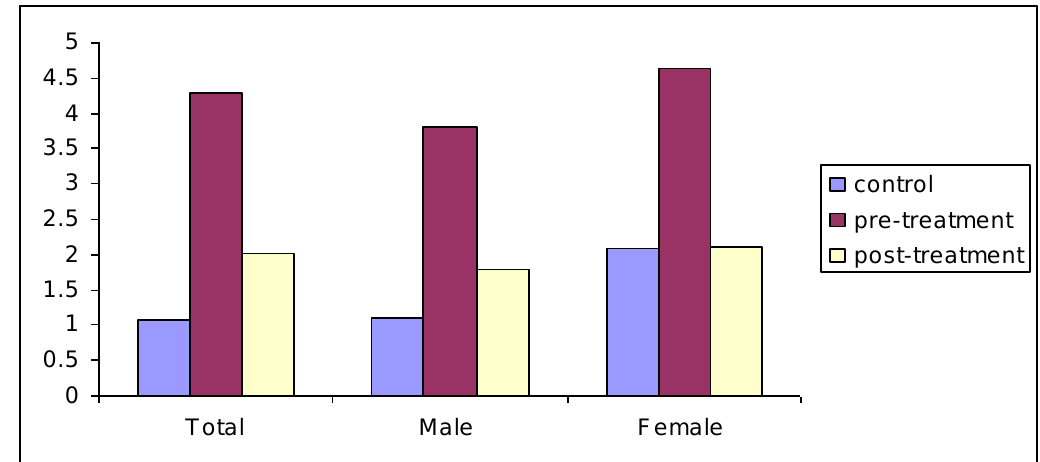
Figure (1): The level of serum C-reactive protein at baseline (pre-treatment), after one month of using chloroquine phosphate (post-treatment) and control.